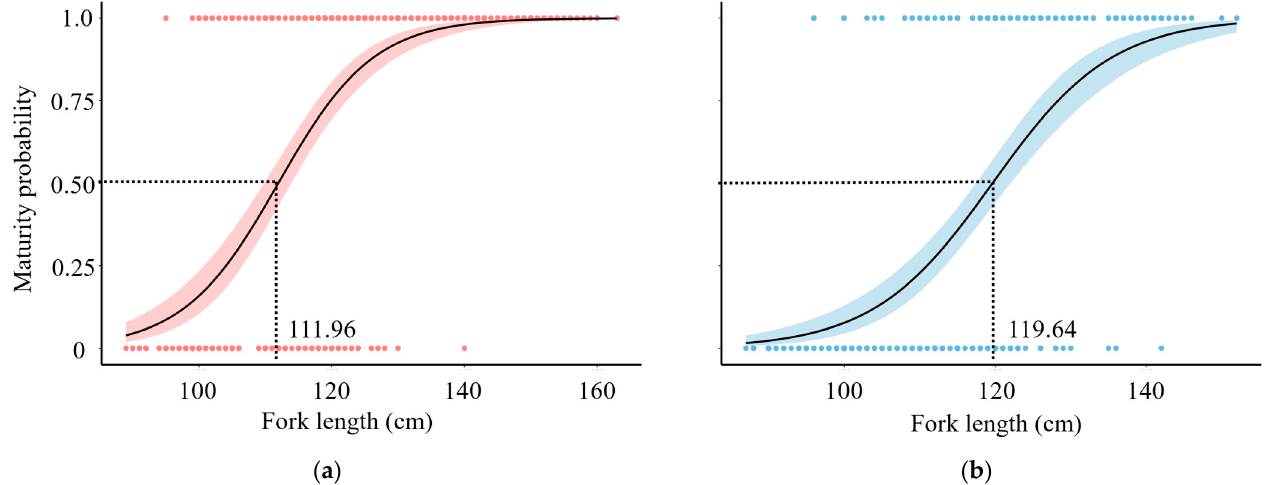
Figure 6. Maturity ogive of ( a ) male and ( b ) female T. albacares . The shaded parts represent 95% confidence interval. The horizontal dotted line represents the proportion at which 50% of the population of T. albacares is mature and the vertical dotted line shows the corresponding FL.